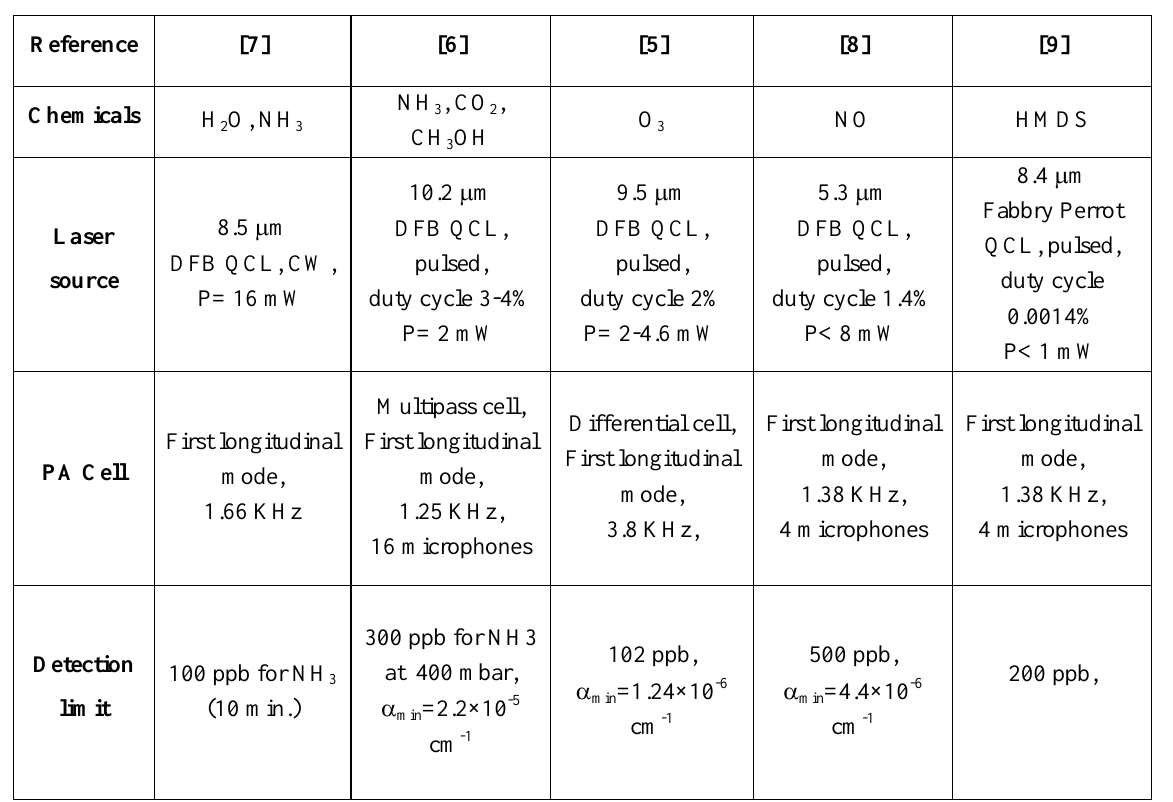
Table 1 . Summary of selected published results on QCL-based photoacoustic spectroscopy gas